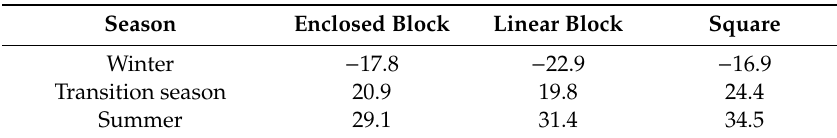
Table 7. Average PET ( ◦ C) of each space